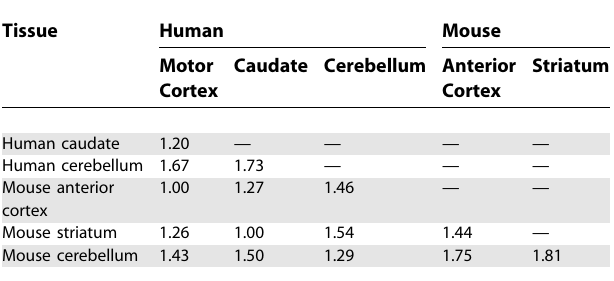
Table 5. Orthologous Brain Regions between Species Are More Similar to Each Other than to Different Regions within a Species